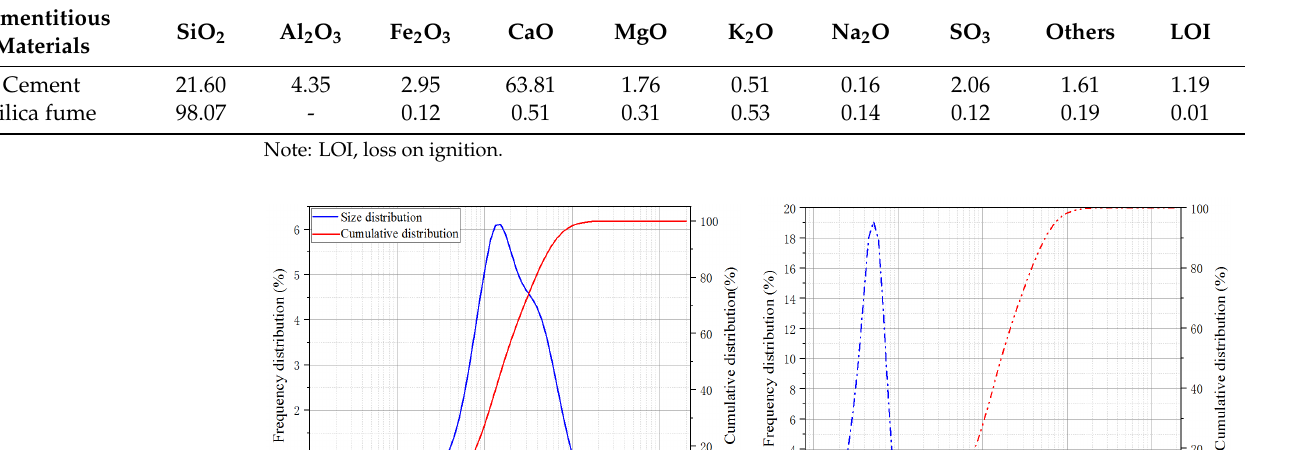
Table 1. Chemical compositions of the cementitious materials (Unit [%]).